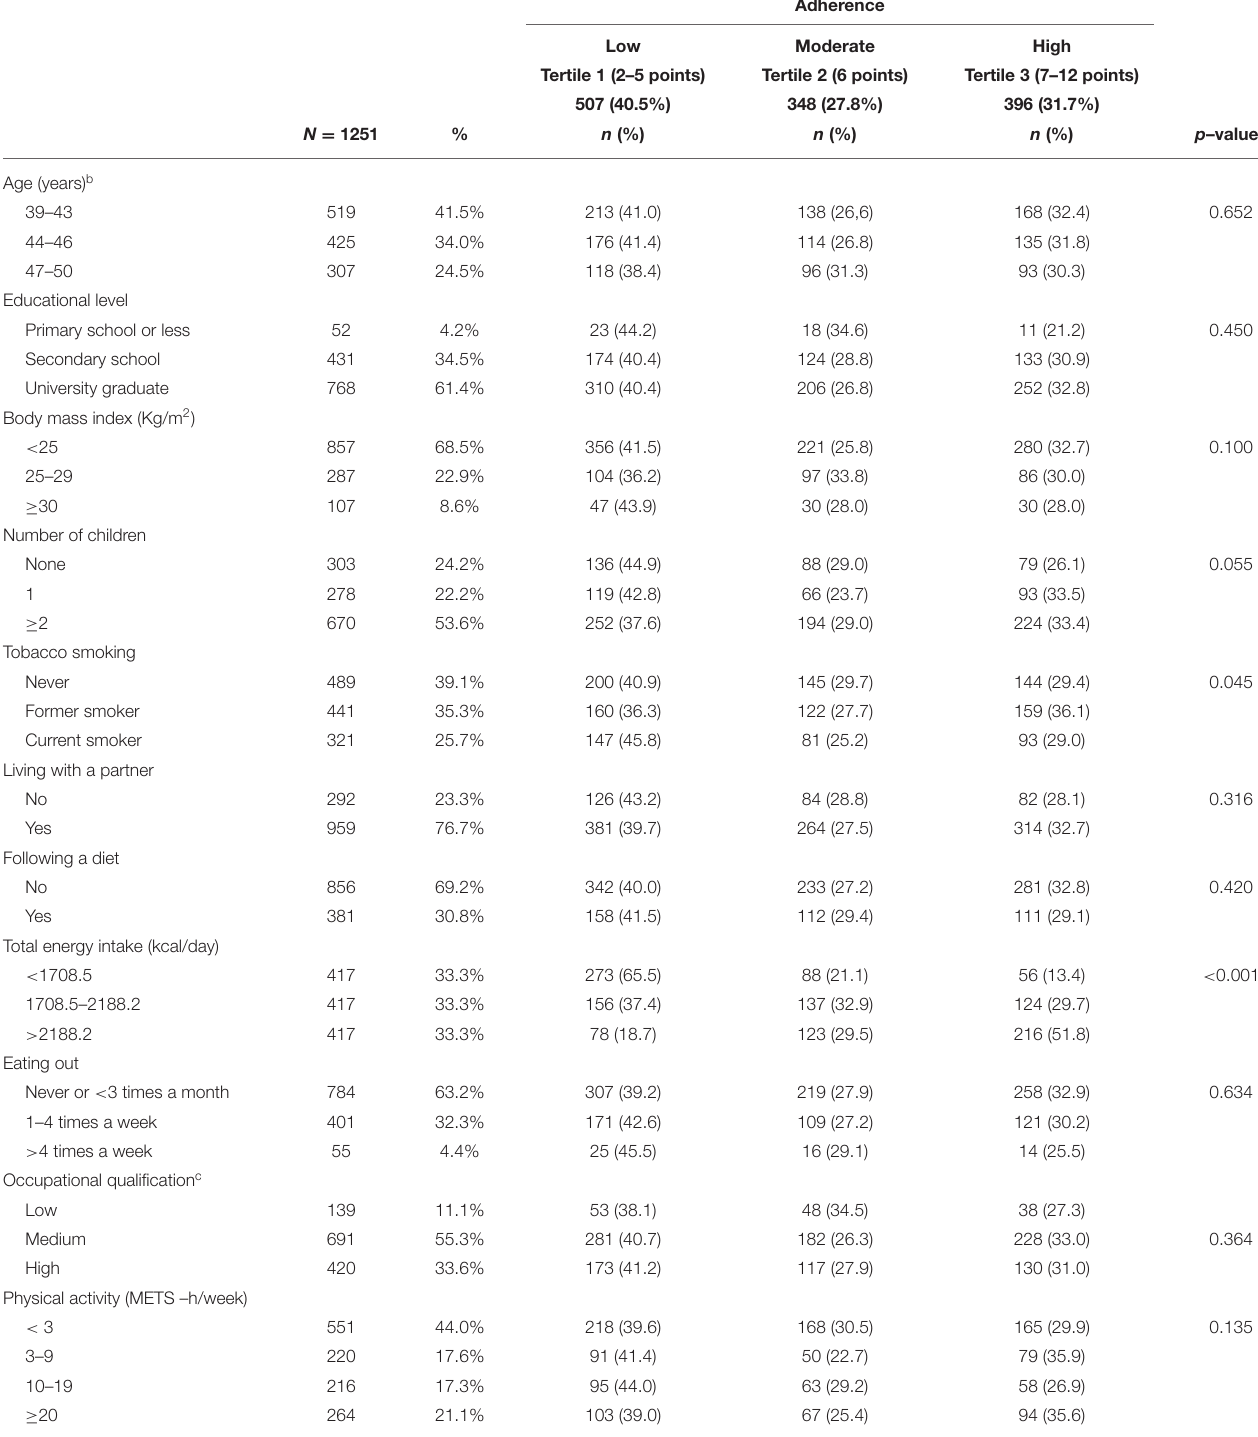
TABLE 4 | Characteristics of the women, overall and by tertiles of the SENC adherence score.